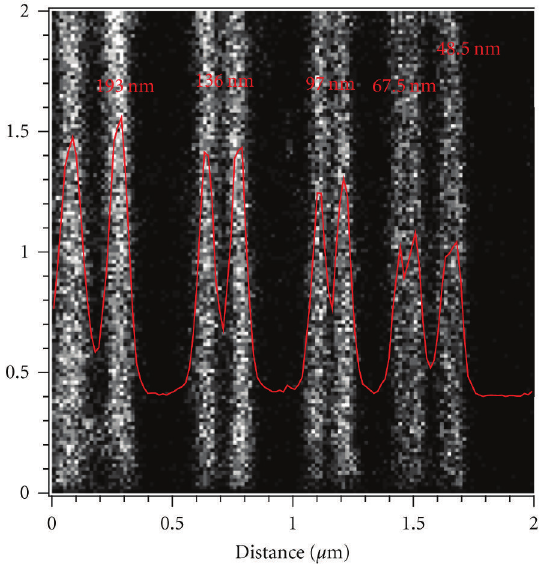
Figure 9: Aluminium secondary ion image from the BAM L200 aluminium/indium/gallium arsenide standard. Field of view 2 × 2 µ m, displayed pixel size 15.6 nm, 30keV, < 1pA primary gallium ion beam. Superimposed in red are the integrated profile, and labels denoting the period of each line pair (see bam l200repe.pdf from http://www.rm-certificates.bam.de/ for more information). The 67.5 nm period line pair (i.e., lines of width 34nm, separated by 34nm) is barely split, but the 97nm period pair (49nm wide lines) is well